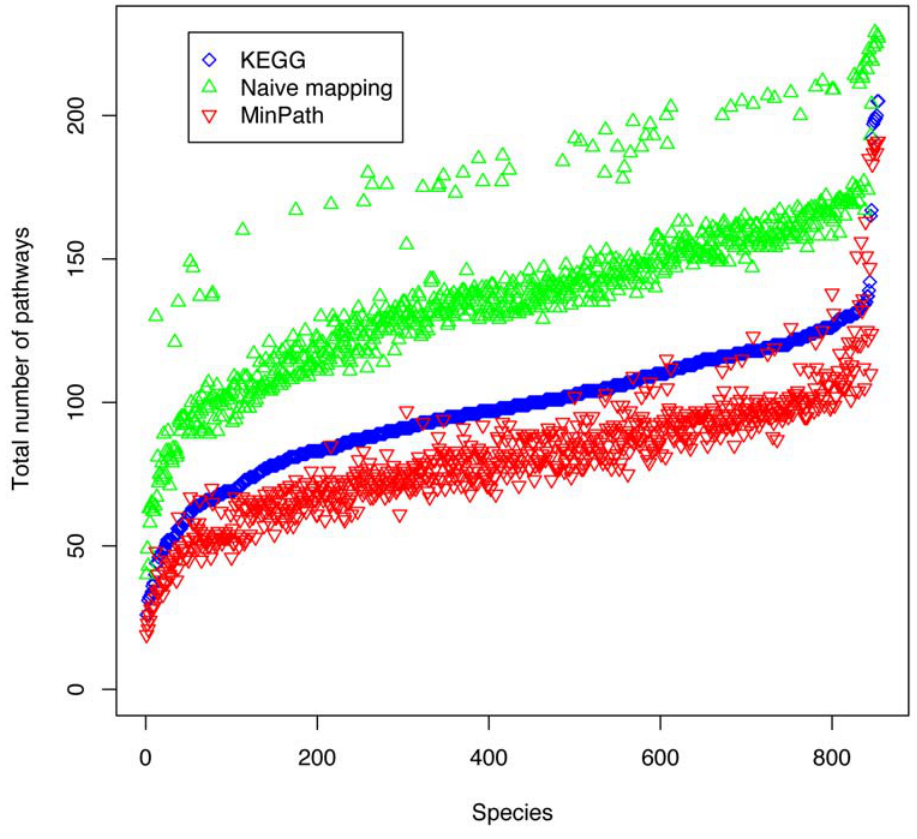
Figure 2. Comparison of the number of pathways reconstructed for various genomes by different methods. The coloring schema is as following: MinPath (red triangles), naı¨ve mapping approach (green), and the pathway annotation maintained in KEGG database after human